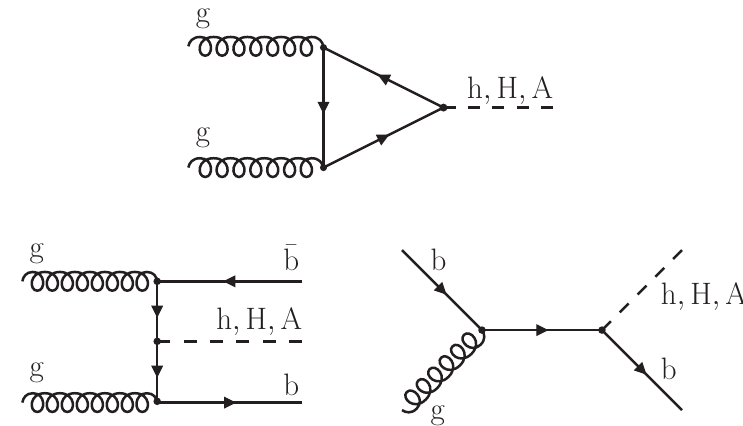
Figure 1: Feynman diagrams of the production modes of an neutral MSSM Higgs boson. (top) Gluon gluon fusion; (bottom-left) b ¯ b -associated production four-flavour scheme; (bottom-right) b ¯ b -associated production five-flavour